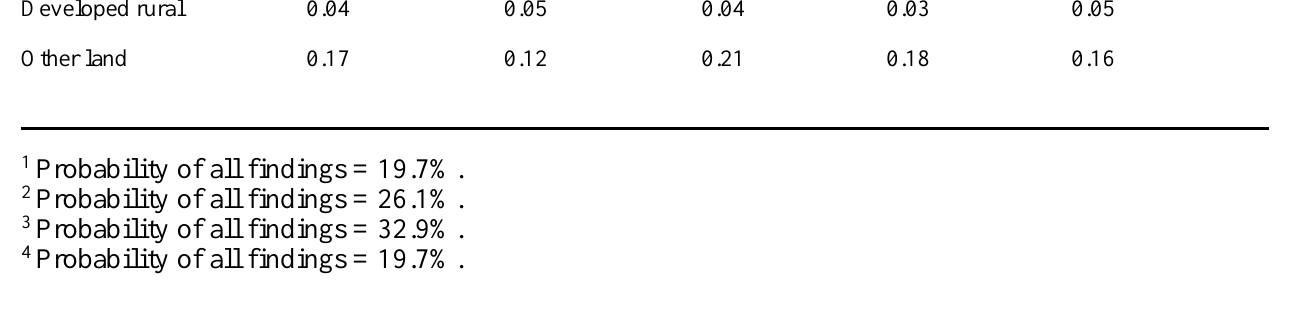
Table 5. Inference results of Model 1 (area of holding). Land cover of Scotland No knowledge Area = small 1 Area = medium 2 Area = large 3 Area = very large 4 Arable land 0.35 0.37 0.36 0.35 0.32 Improved grassland 0.15 0.12 0.16 0.17 0.16 Rough grazing 0.08 0.08 0.08 0.09 Forest 0.20 0.26 Developed rural Other